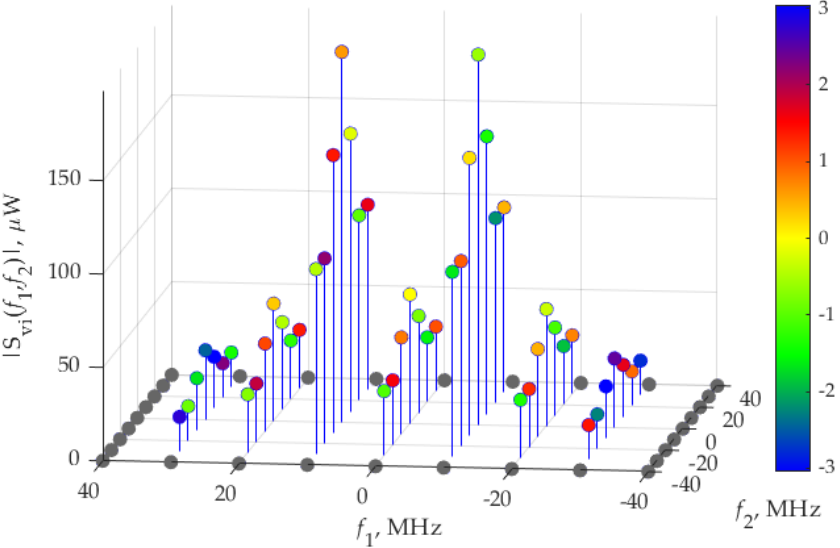
Figure 4. The bifrequency spectrum for the case of finite sum of harmonics current. The absolute values, in μW , and phases, in radians, of the delta function weights forming the bifrequency spectrum, S vi ( f 1 , f 2 ), are presented in Table 1, where each cell cor- responds to a pair of frequencies, f 1 and f 2 , defined in the rows and columns, respectively. Table 1. The amplitudes and phases of the bifrequency spectrum.